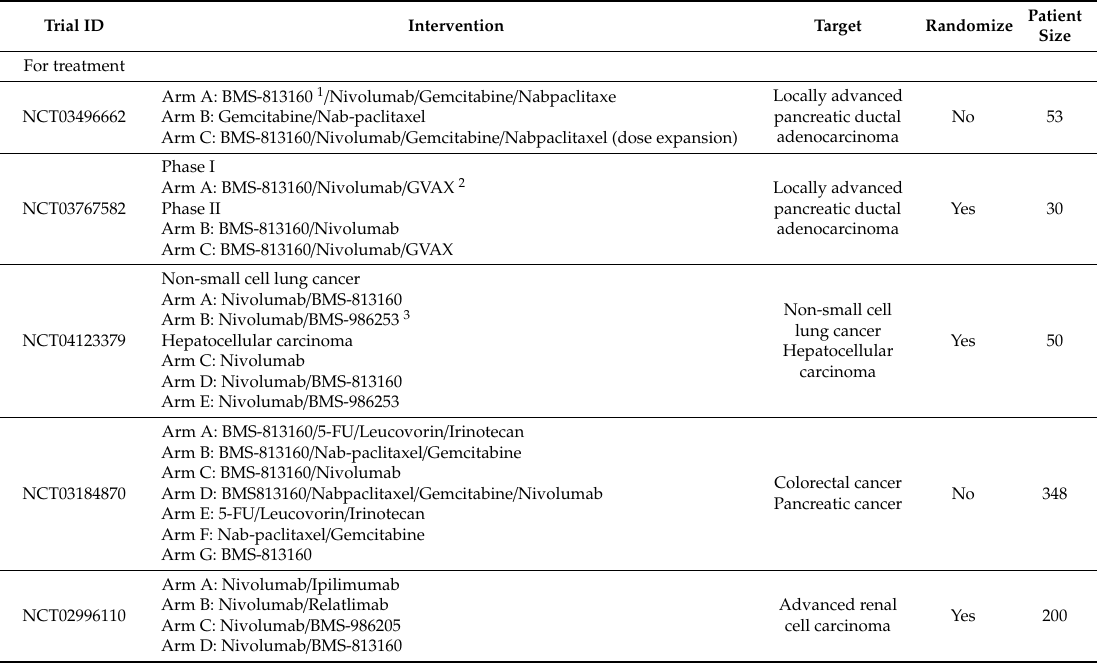
Table 2. Ongoing clinical trials of CCR2 inhibitors and CCR2